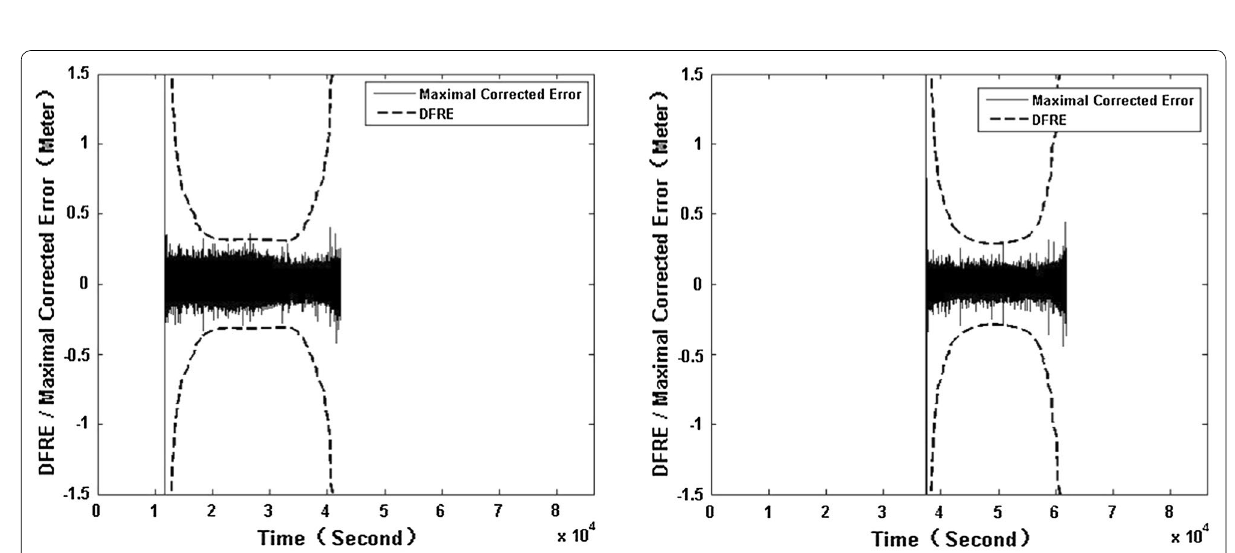
Fig. 4 DFRE versus maximal corrected error of BDS MEO18 (left) and GPS PRN15